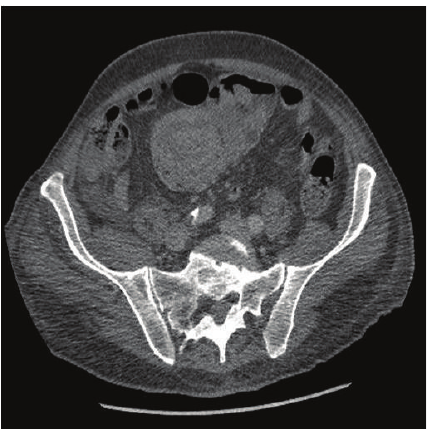
Figure 1: CT scan illustrating the area of intussusception.